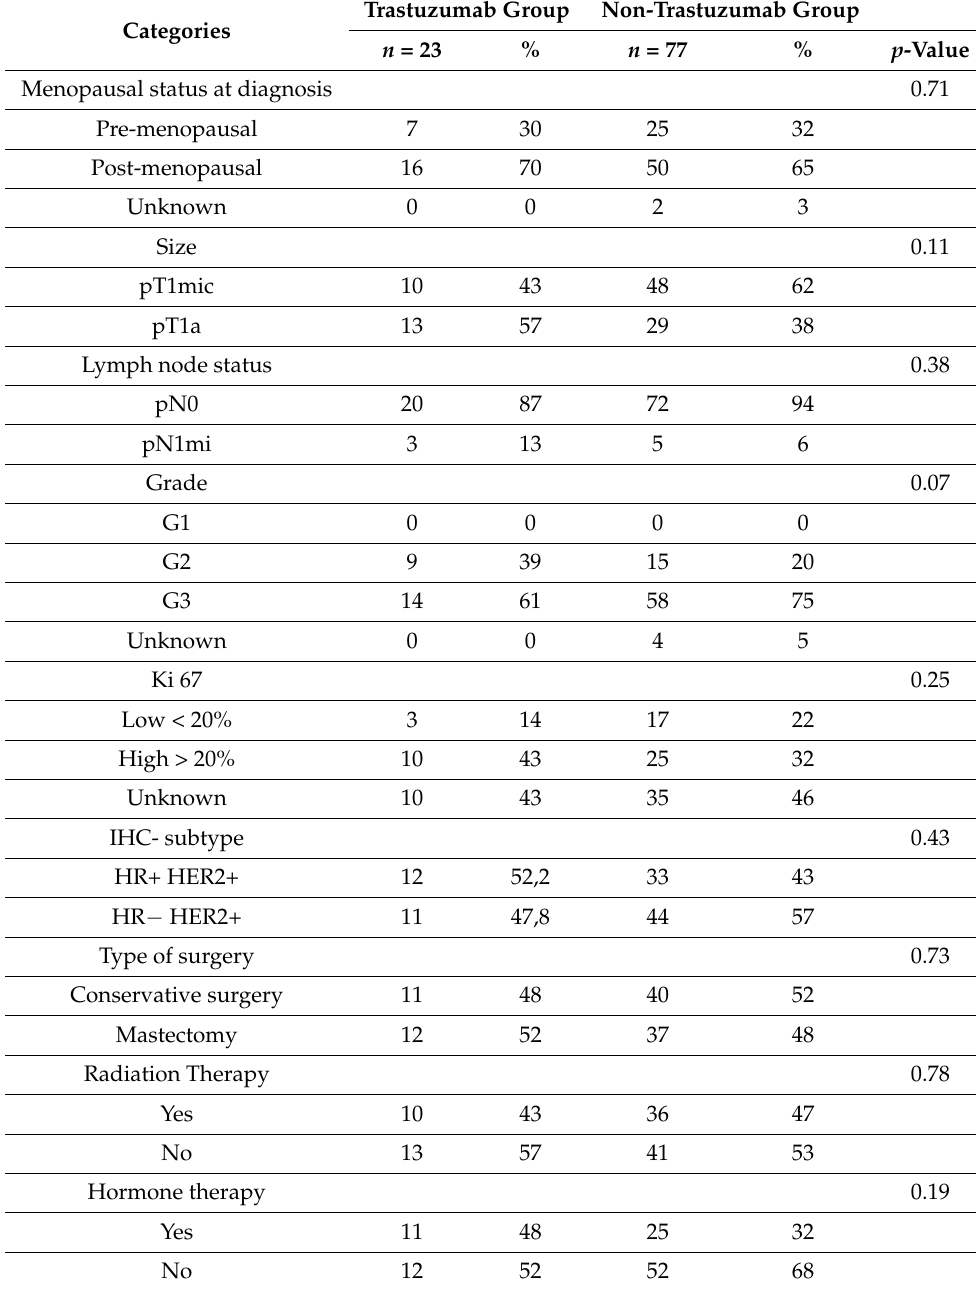
Table 4. Clinic-pathological features of patients who received Trastuzumab vs. patients who did not receive